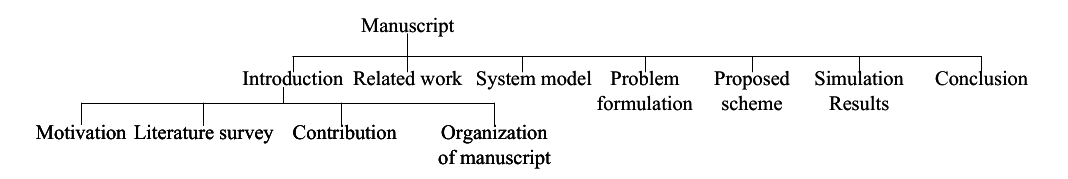
Figure 2. Flow schematic overview of the